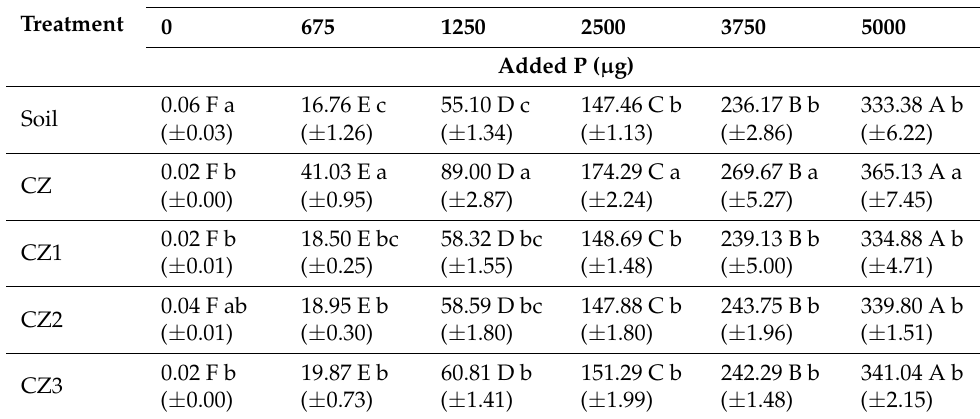
Table 5. Interactive effects of the different concentrations of phosphorus and treatments (Soil only, clinoptilolite zeolite only, clinoptilolite zeolite only, and soil with different amounts of clinoptilolite zeolite) on phosphorus